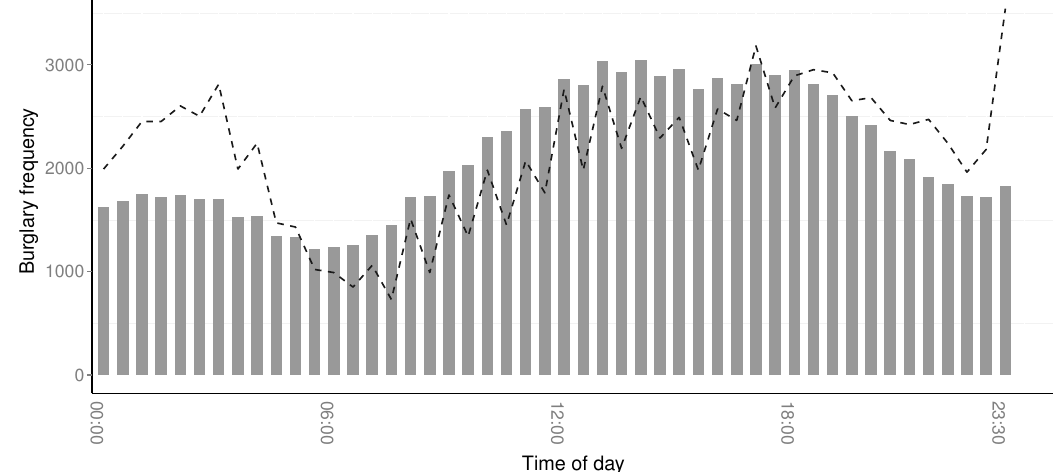
Figure 2. Aoristic distribution of all burglaries and attempted burglaries with an hour resolution between 2010 and 2014 with the baseline shown as a dashed